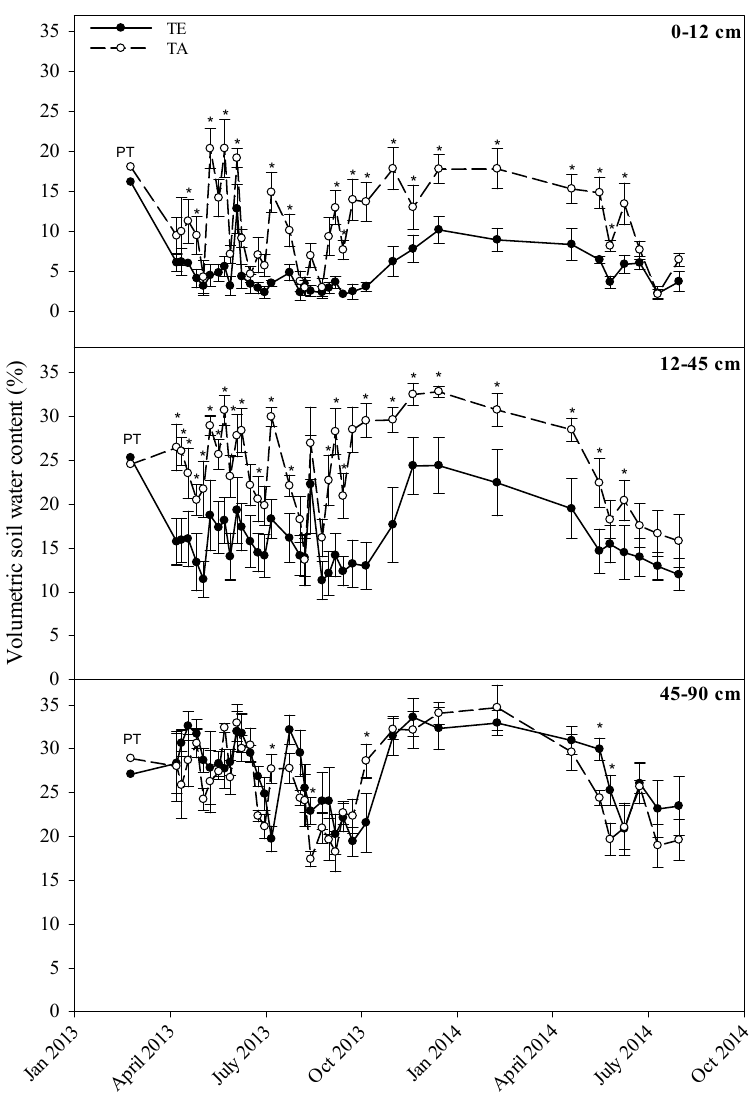
Figure 4. Mean volumetric soil water content (%) between 0–12 cm, 12–45 cm, and 45–90 cm in response to 100% throughfall exclusion (TE) and ambient throughfall (TA) treatments. An asterisk (*) above the data represents dates that treatments are significantly different ( p < 0.1 ( n = 5)). Pre-treatment (PT) represents measurements before treatment application.